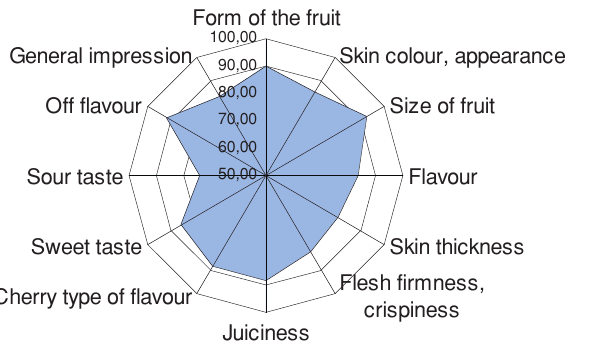
Figure 9. Profile diagram of the sensorial judgement of the variety Vera (NK)